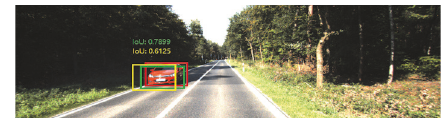
Figure 9: IoU of two methods compared with ground-truth.